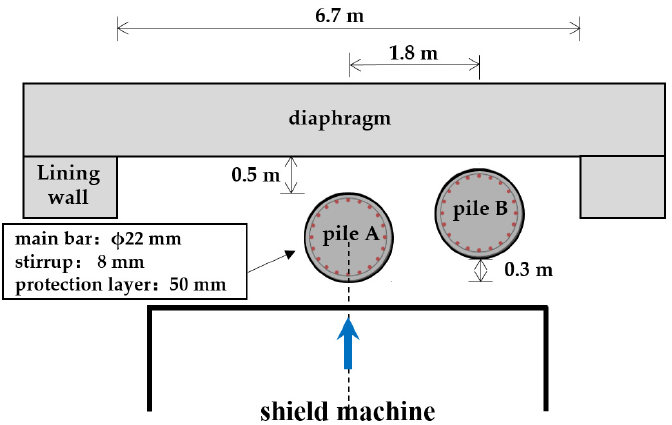
Figure 8. Photo of the field test site.